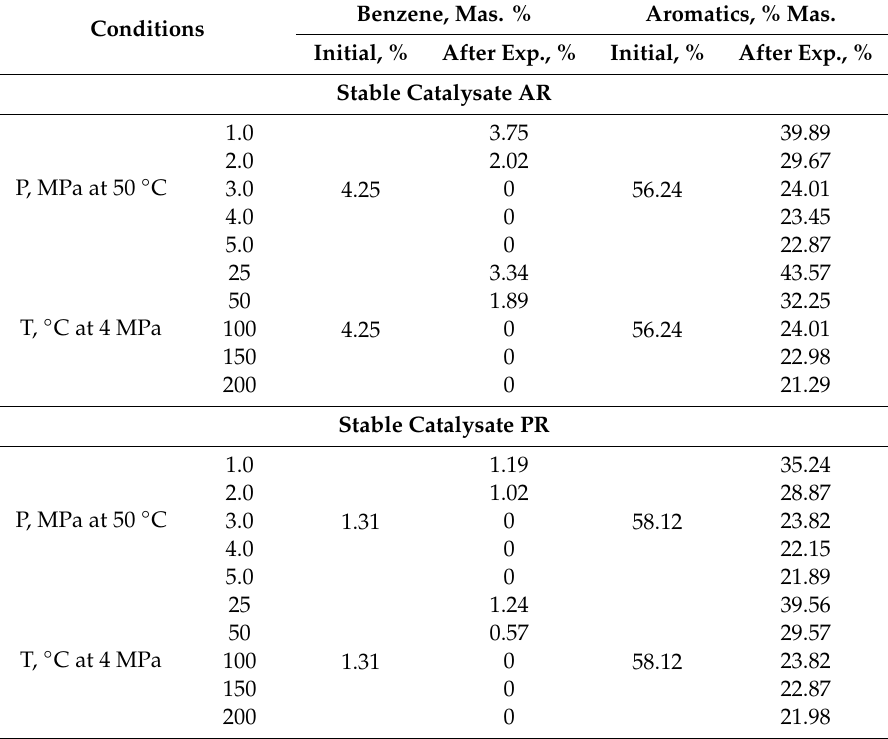
Table 2. Hydrodearomatization of fractions of stable catalysate AR and stable catalysate PR over the 0.5% Rh-Pt / γ -Al 2 O 3